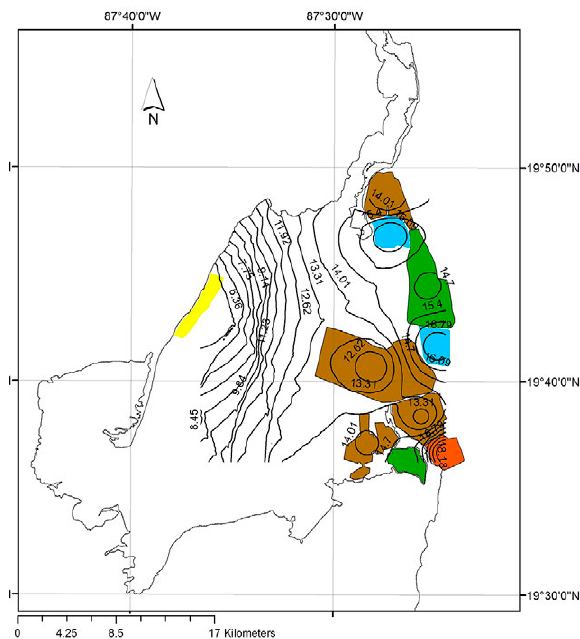
Fig. 6. – Five homogenous groups of fishing areas (orange, blue, green, brown and yellow) and isolines for the mean quasi-profits of variable costs per artificial shelter harvested per trip (USD) identi- fied using a Tukey HSD test.